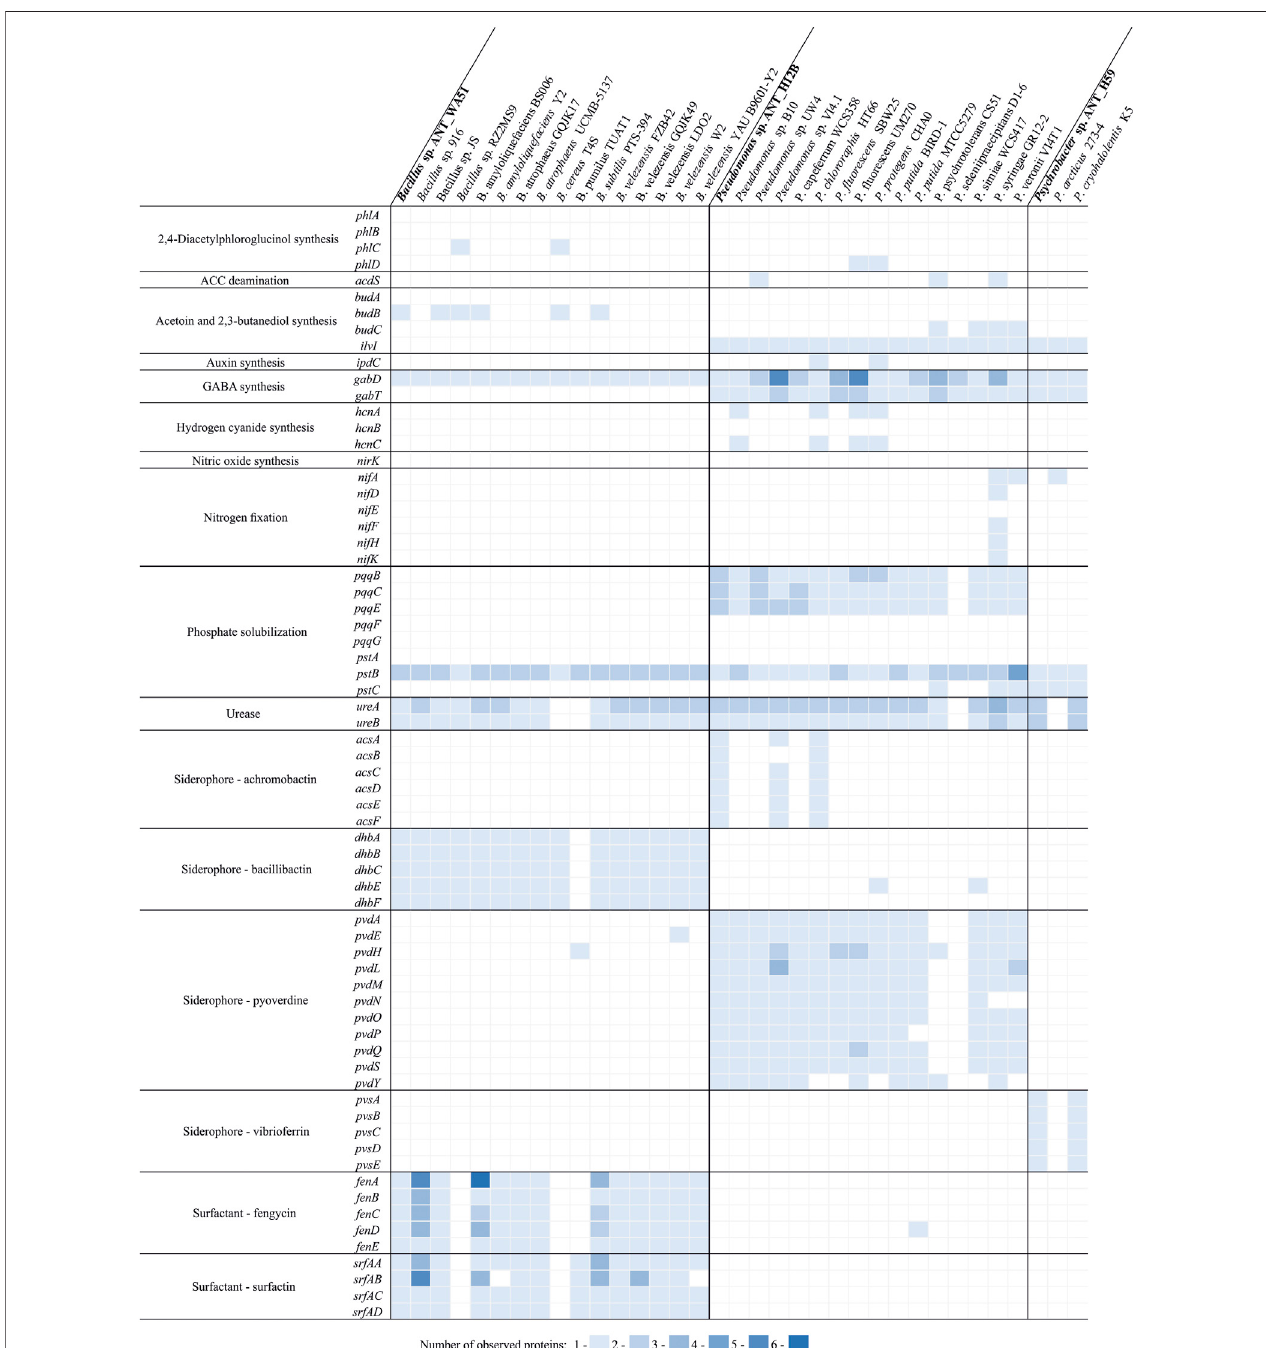
FIGURE 3 | Distribution of various plant growth promoting traits in the proteomes of ef fi cient plant growth promoters of the genus Bacillus and Pseudomonas , as well as the reference Psychrobacter strains.